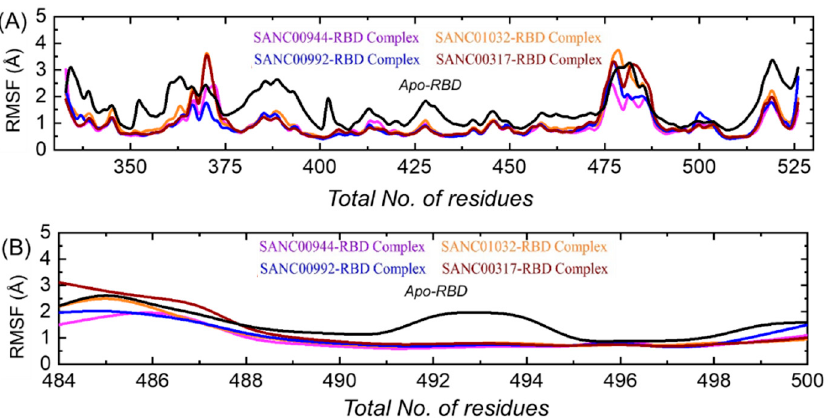
Figure 9. ( A ) Residual flexibility analysis of the SANC01032–RBD, SANC01032–RBD, SANC00992– RBD, and SANC00317–RBD complexes and Apo RBD. ( B ) Flexibility indices of the three binding loops (484–500) required for interactions.